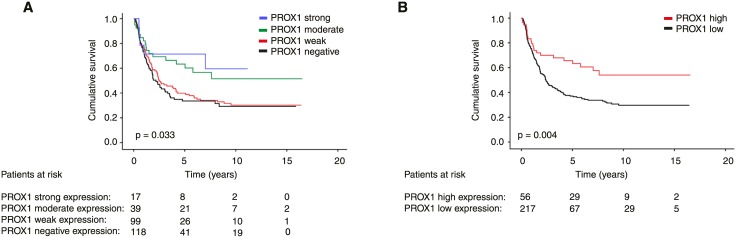
Gastric cancer-specific survival according to the Kaplan-Meier method, (A) cytoplasmic PROX1 immunoexpression and (B) grouped into high (strong and moderate staining) and low (weak and negative staining) expression.P-value for log-rank test.